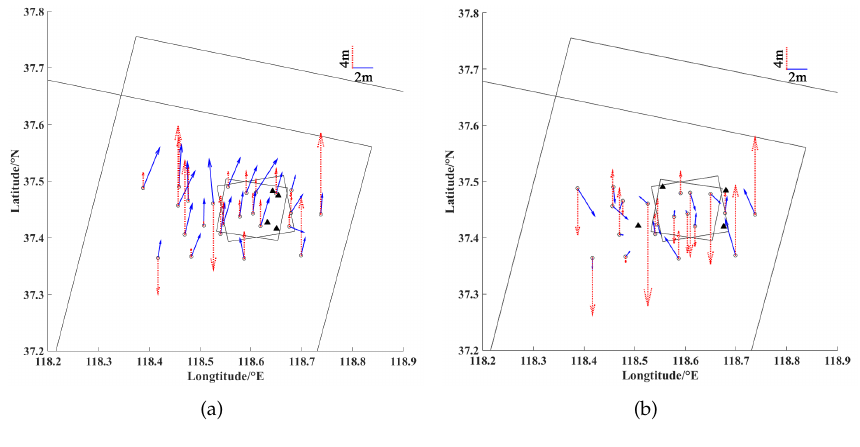
Figure 13. Geometric accuracy improvement analysis: ( a ) GF6, GF3, and GLAS combined geopositioning and ( b ) GF6 with four